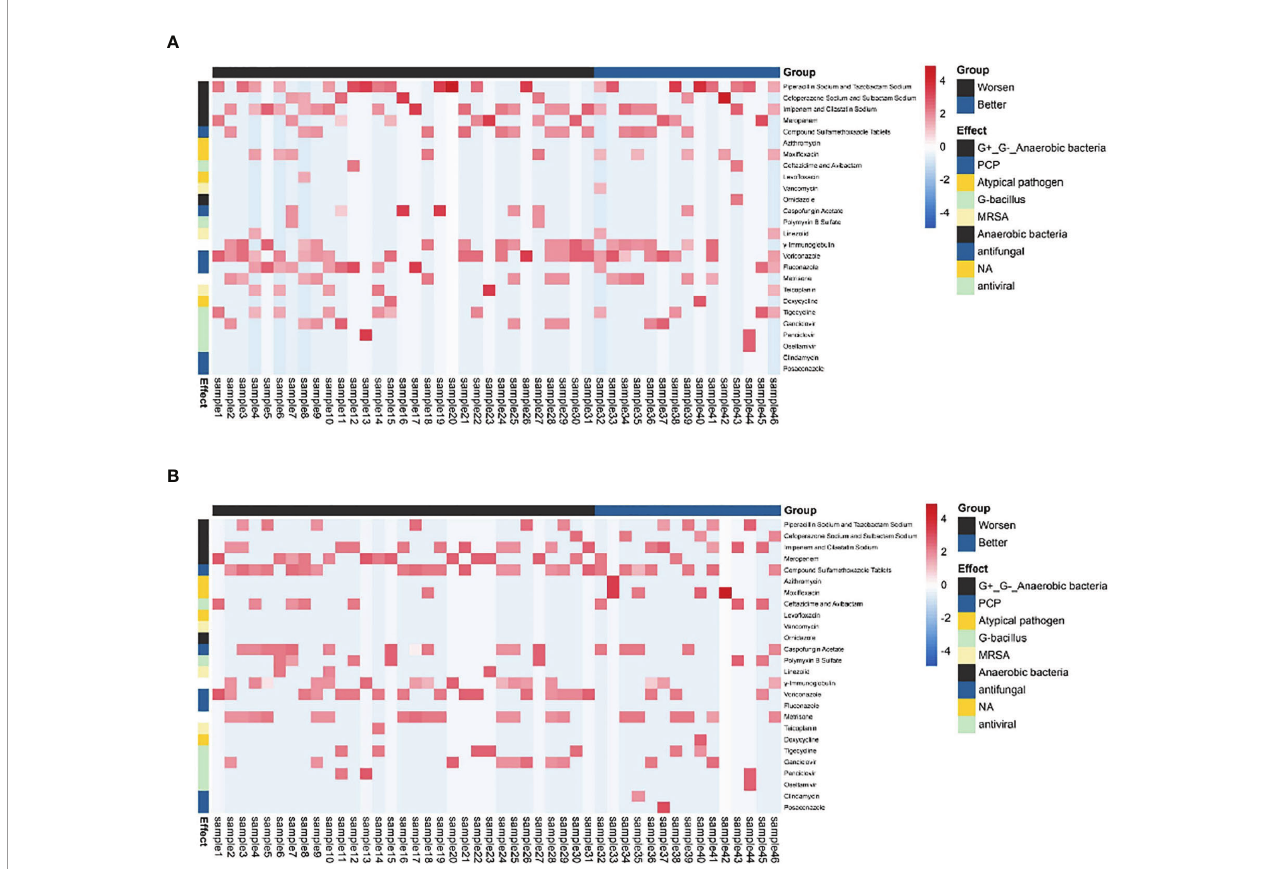
FIGURE 4 | The antibiotic usage of patients. (A) The use of antibiotics before being assisted by the ECMO. (B) The use of antibiotics after ECMO was removed. The heatmaps were drawn using log10 (days of drug treatment), and all of the drugs were divided into eight categories according to their function. NA, no clear classi fi cation; ECMO, extracorporeal membrane